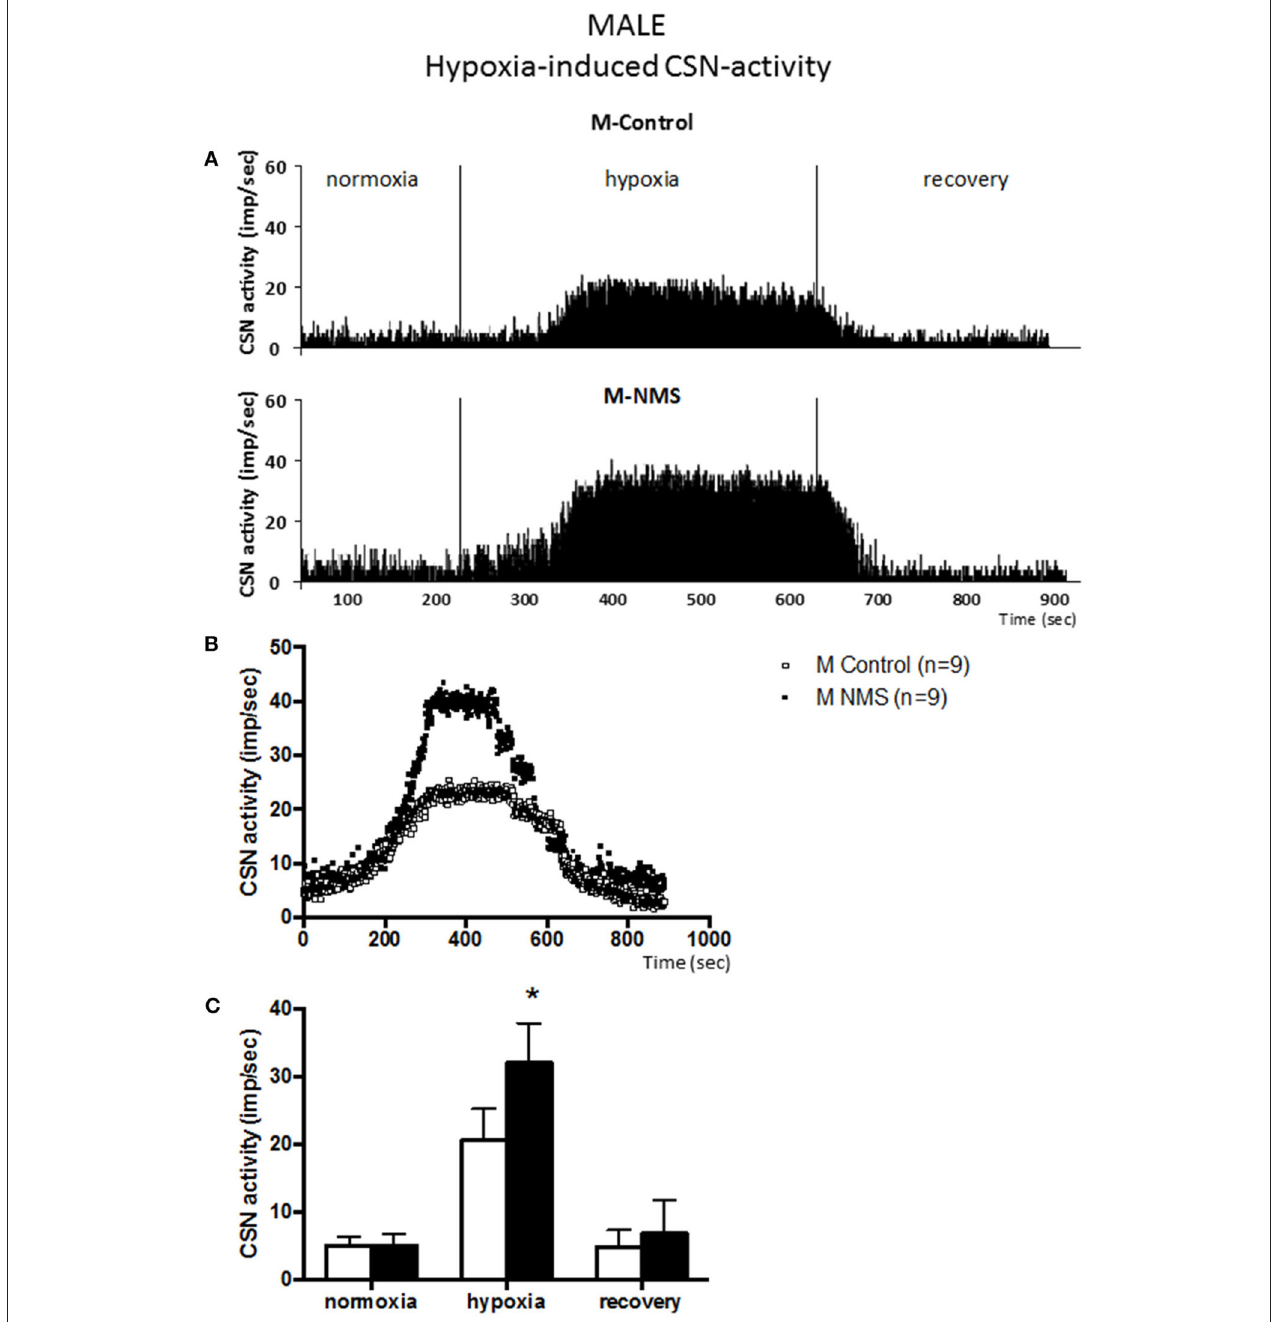
FIGURE 1 | Neonatal maternal separation (NMS) increases carotid sinus nerve (CSN) response to hypoxia in male rats. (A) Original recordings comparing CSN activity from ex vivo preparations of perfused carotid body/CSN from control and NMS males under hyperoxia (FiO 2 = 0.95), hypoxia (FiO 2 = 0.0) and hyperoxic after hypoxia (recovery). (B) Comparison of the mean carotid sinus nerve activity (imp/sec) over the course of the hypoxic protocol between carotid bodies from control (open squares; n = 8) and NMS rats (black squares; n = 8). Hypoxia begins at T = 0 and is maintained until T = 500s (end of plateau phase), followed by hyperoxic recovery; each data point represents the mean value on a second by second basis. (C) Histograms comparing mean CSN activity for each specific experimental condition between control (white bars; n = 8) and NMS (black bars; n = 8) male rats. Data are reported as means ± SD . *indicates a value statistically different from control at p ≤